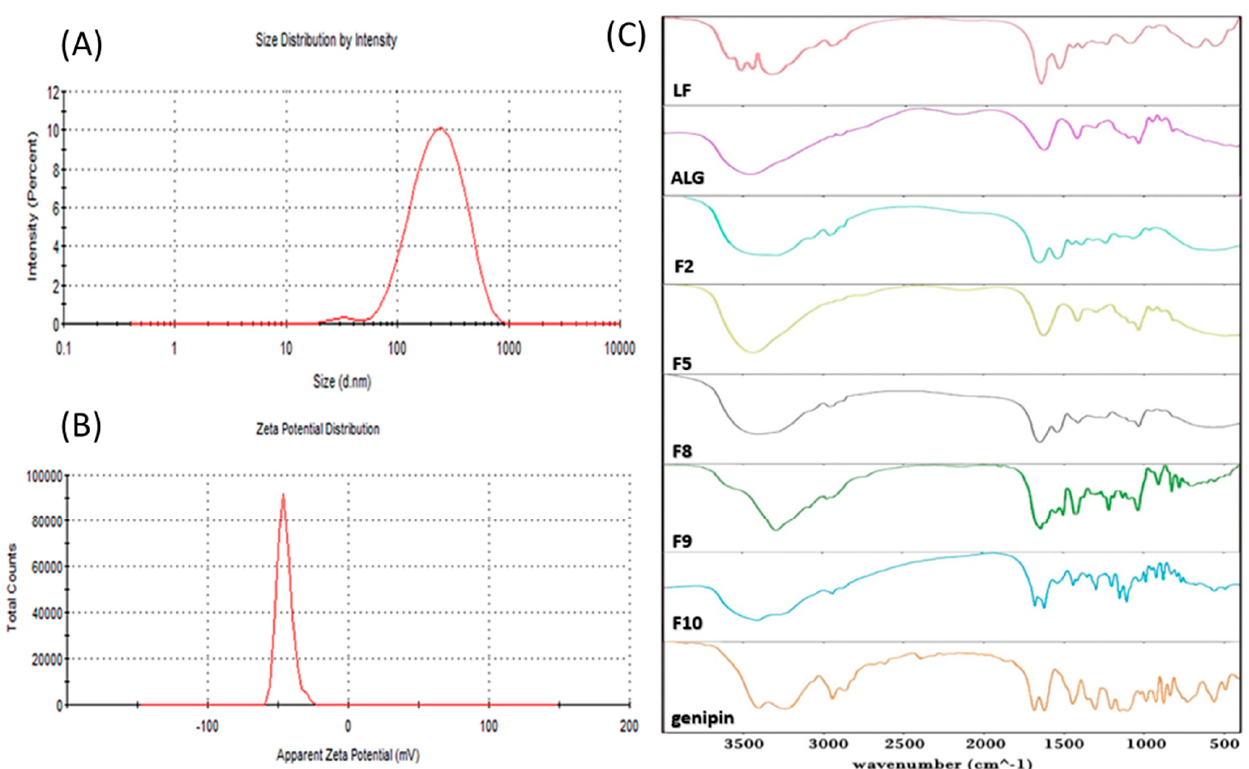
Figure 3. ( A ) Size distribution diagram of crosslinked HK-loaded PMT–ALG/LF–RST NHs F10 ; ( B ) ζ potential of NHs F10 and ( C ) Fourier transform infrared (FTIR) spectra of LF, ALG, LF–RST F2 , PMT–ALG F5, PMT–ALG/LF–RST F8 , HK-loaded PMT–ALG/LF–RST F9 , genipin and crosslinked HK-loaded PMT–ALG/LF–RST NHs F10 . Table 2. Effect of genipin amounts on zeta potential, PDI and particle size of nanohybrids F10 ( n = 3). Amount of Genipin (mg)